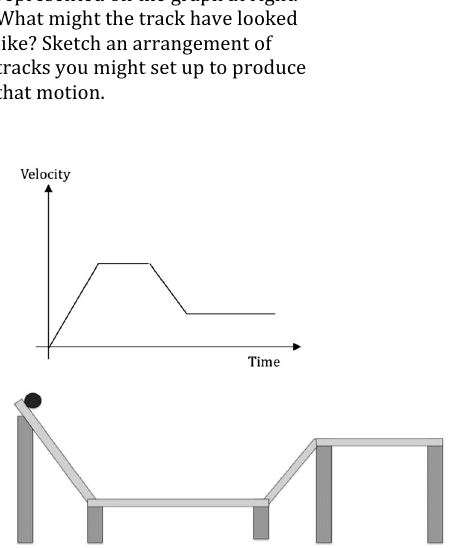
FIG. 1. A tutorial problem showing a velocity-time graph and the track that is the correct